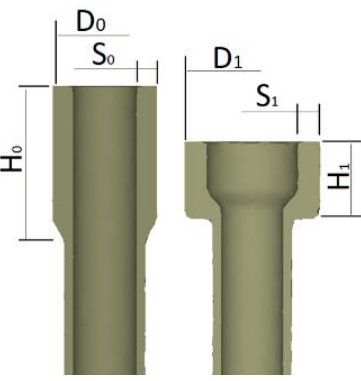
Figure 3. Geometric parameters of the workpiece and part after tube forming.